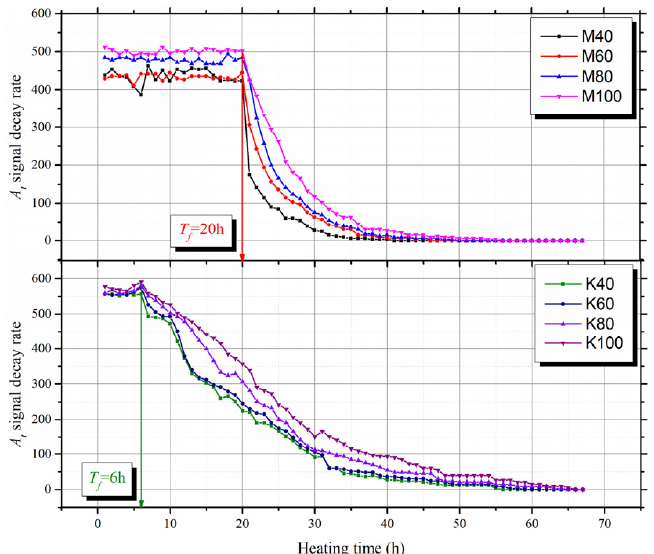
Figure 9. Variation of the At decay rate with respect to the heating time. From top to bottom, curves with different colors and symbols with different shapes indicate variation of M40, M60, M80, M100, K40, K60, K80, and K100, respectively. The scales of the Y axes of the upper and lower parts of the figure are different. Red and olive vertical line indicate 20 and 6 h, respectively. T f is the time when the decay rate started to fall.